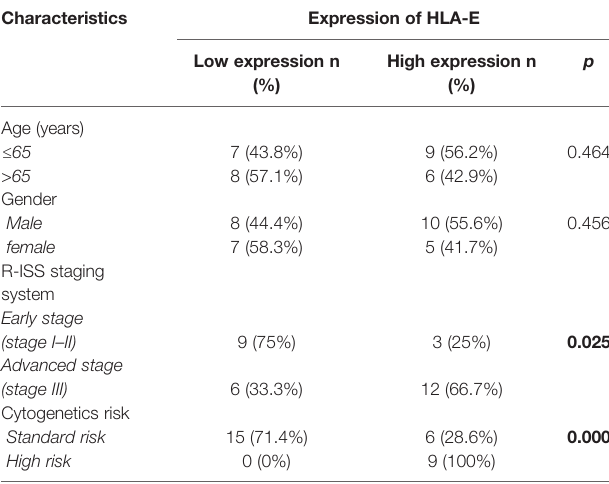
TABLE 2 | The relationship between HLA-E and clinical parameters.